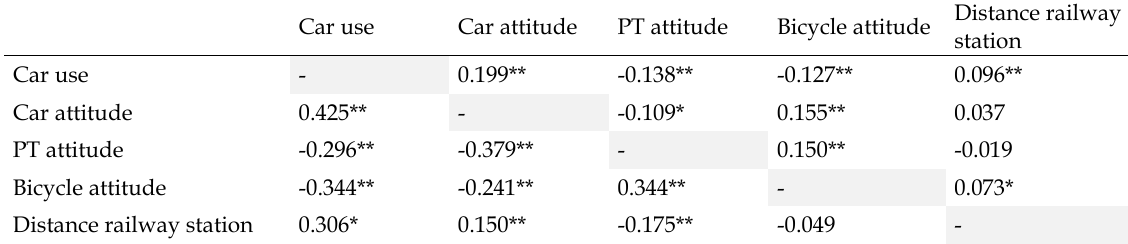
Table 4. Correlations between error terms of endogenous variables in 2005 and 2012 Car use Car attitude PT attitude Bicycle attitude